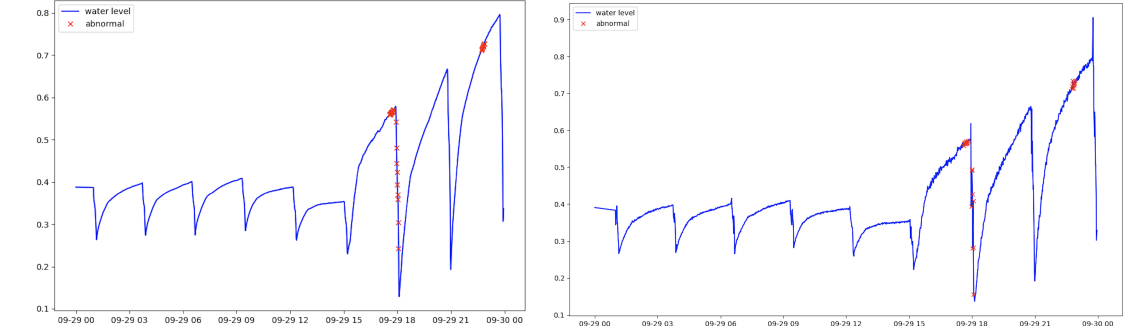
Figure 5. Comparison of dual-staged one-class SVM on the anomaly detection.